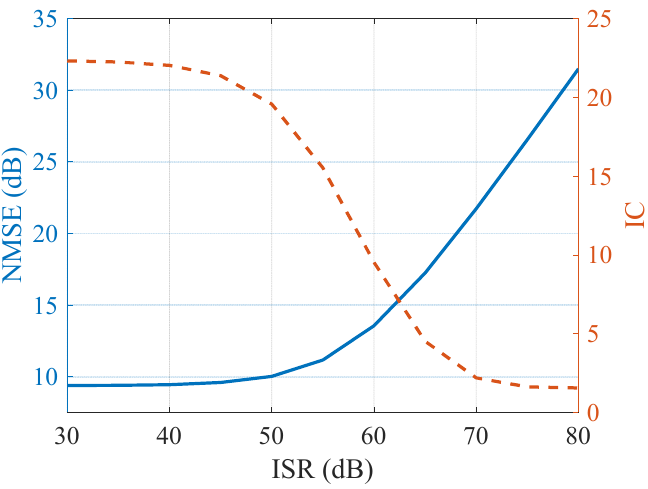
Figure 12. NMSEs and ICs of the target images obtained by the 3D IFFT under different ISRs with random WBI parameters.